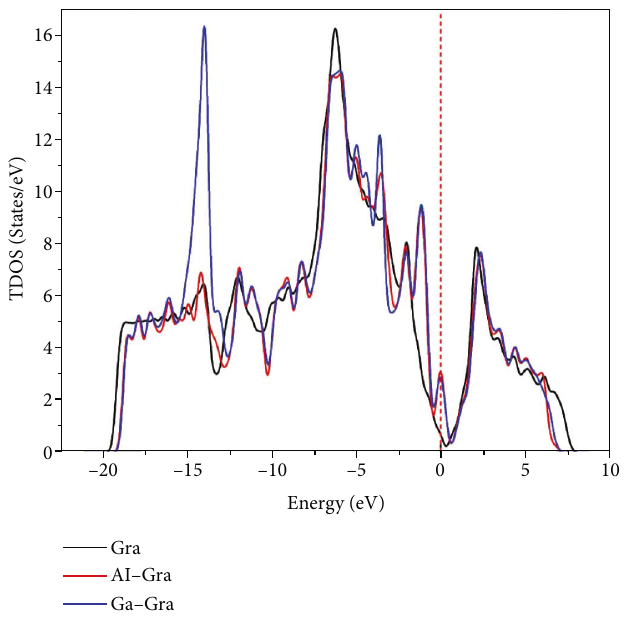
Figure 2: The TDOS con fi guration of graphene, Al- and Ga-doped